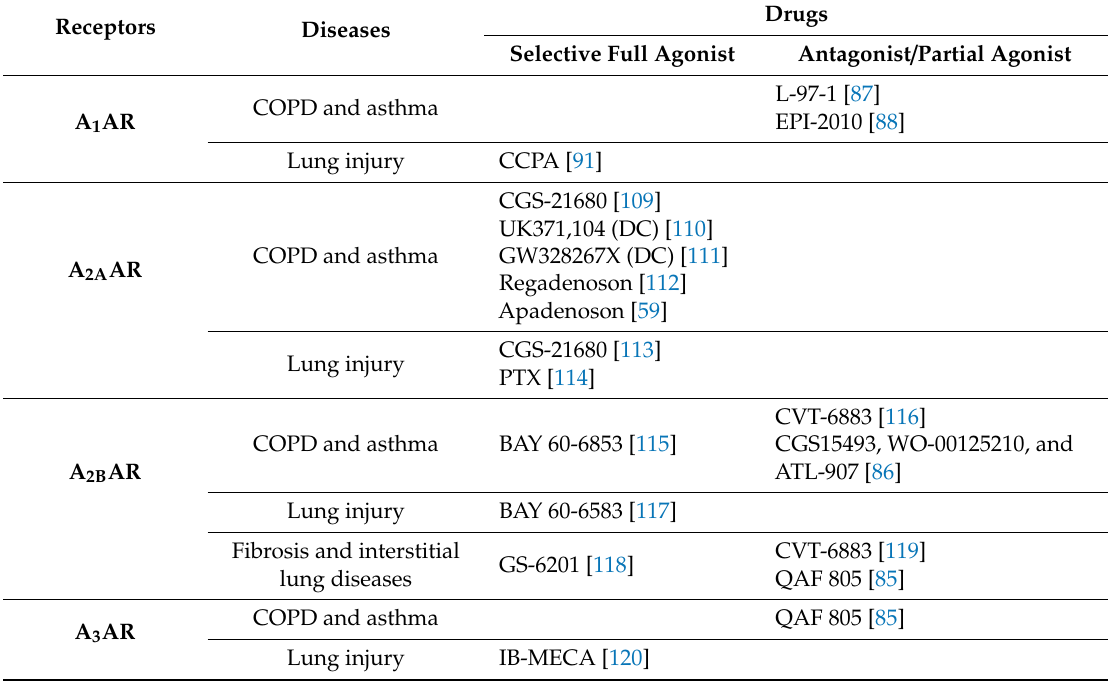
Table 1. Adenosine receptor drugs in respiratory